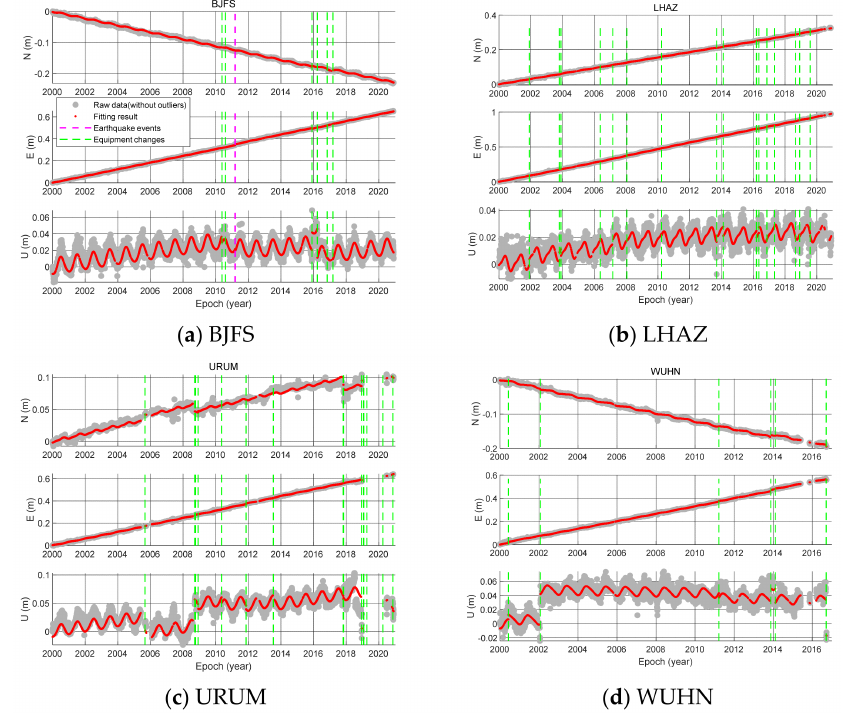
Figure 3. GNSS coordinate time series fitting results of BJFS, LHAZ, URUM and WUHN